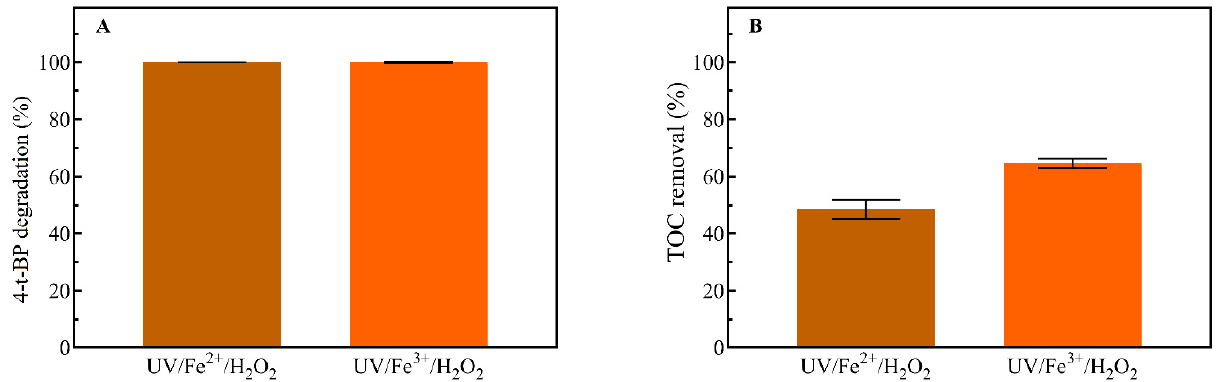
Figure 4. 4-t-BP degradation ( A ) and TOC removal ( B ) in the Fe 2+ /UV/H 2 O 2 and Fe 3+ /UV/H 2 O 2 at optimal conditions (con- ditions: space time = 60 min, 5 mg/L of catalyst, [H 2 O 2 ] = 176.6 mg/L).